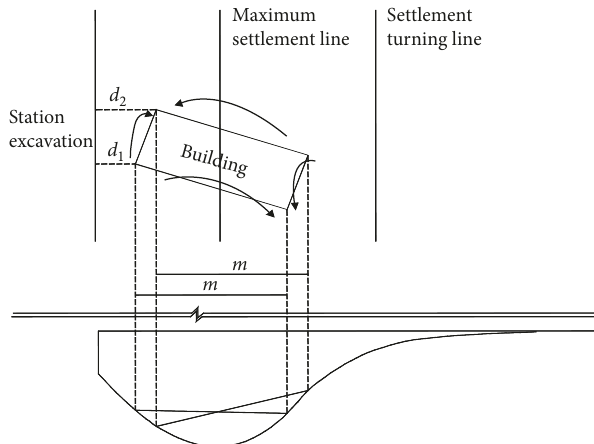
Figure 9: Torsional deformation of a building across the maximum settlement line.